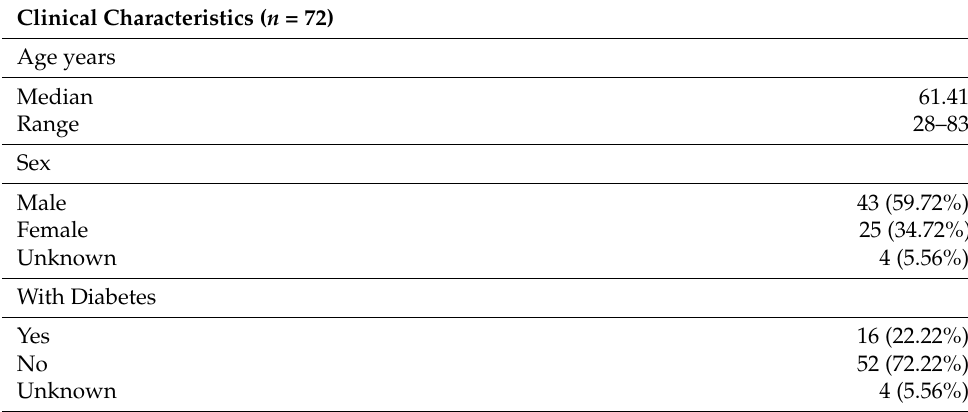
Table 1. Clinical characteristics of 72 patients with